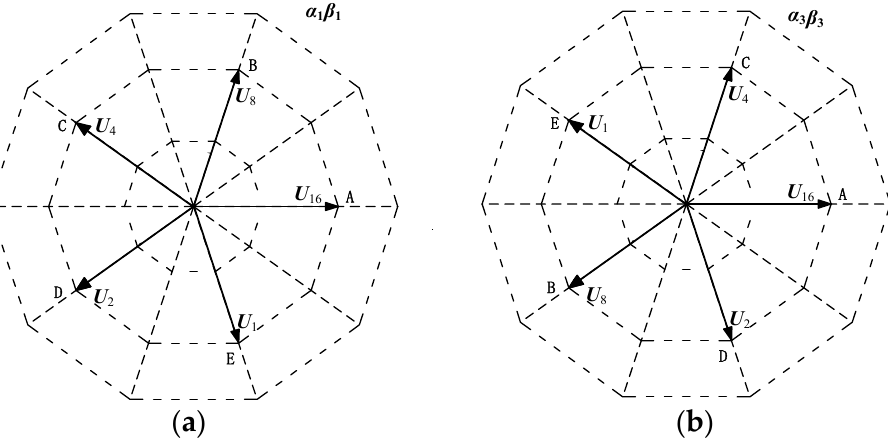
Figure 1. The space distribution of five − phase VSI in double subspace: ( a ) in fundamental subspace ( b ) in harmonic subspace.